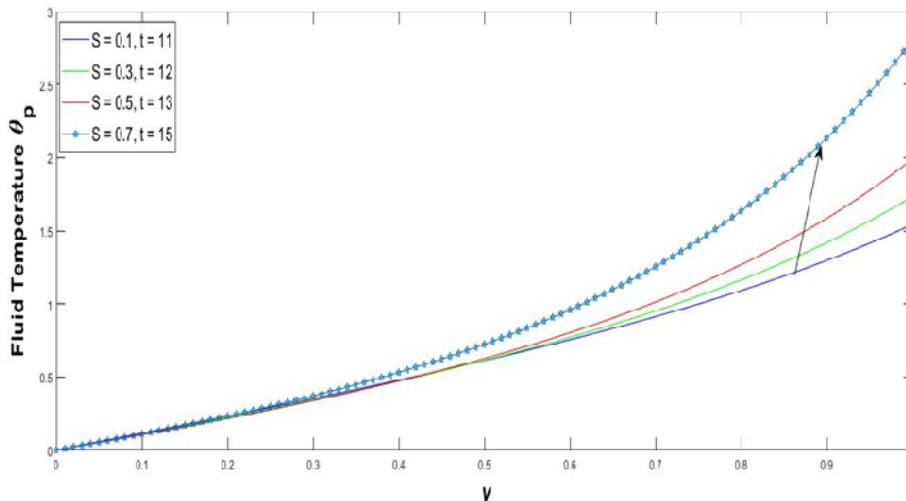
Figure 24. Temperature field for suction parameter.